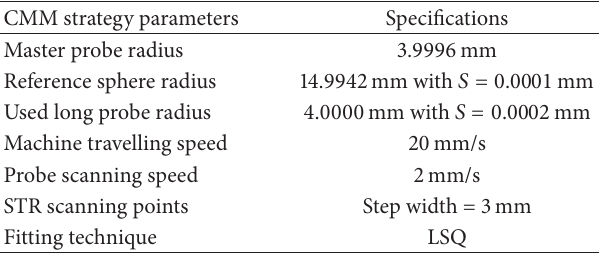
Table 1: CMM set-up and measurement